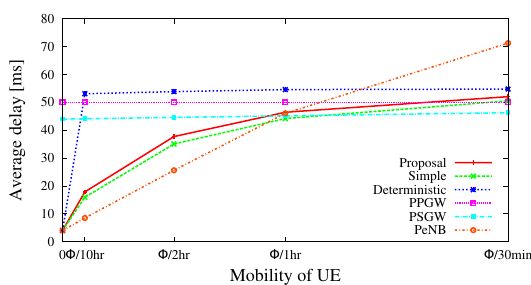
Figure 7: Number of UE context migrations in